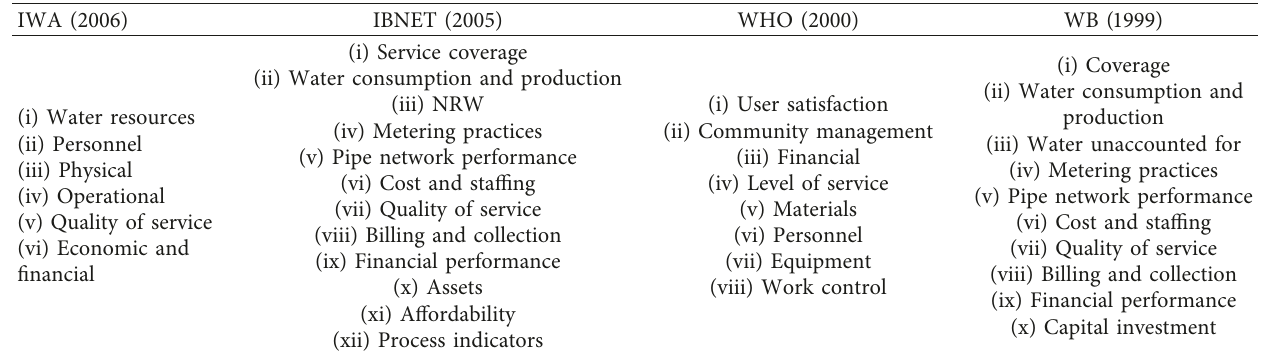
Table 2: PI themes recommended by international organizations [7,